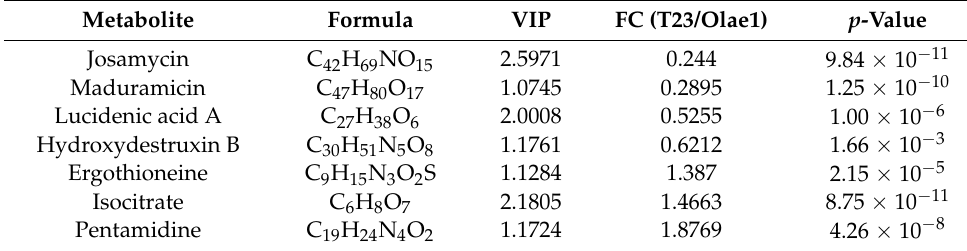
Table 2. Key metabolites with significant differences between T23 and Olae1